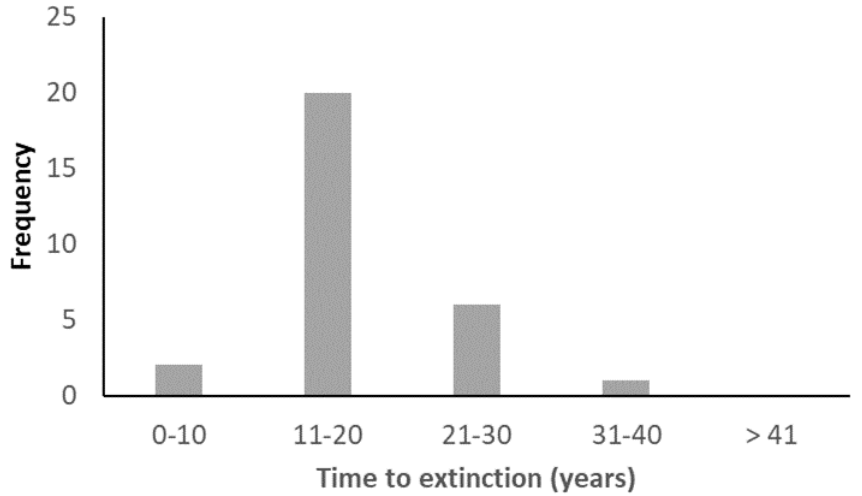
Figure 4. Number of simulations ( n = 30) and the period of time (in years) where the simulated manatee population manages to survive (i.e., until the last individual disappears from the lake).